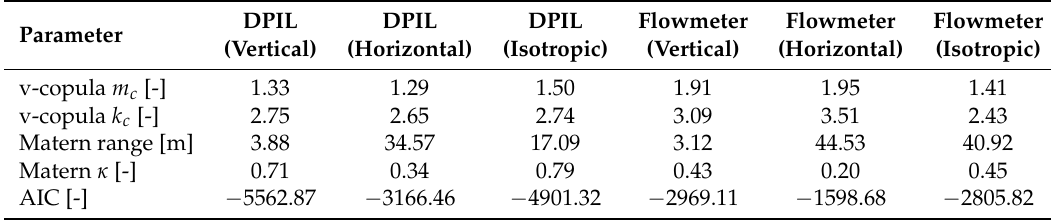
Table 2. Representative parameter estimates for the v-copula model based on 200 randomly sampled data subsets of size 10, with the related Akaike information criterion